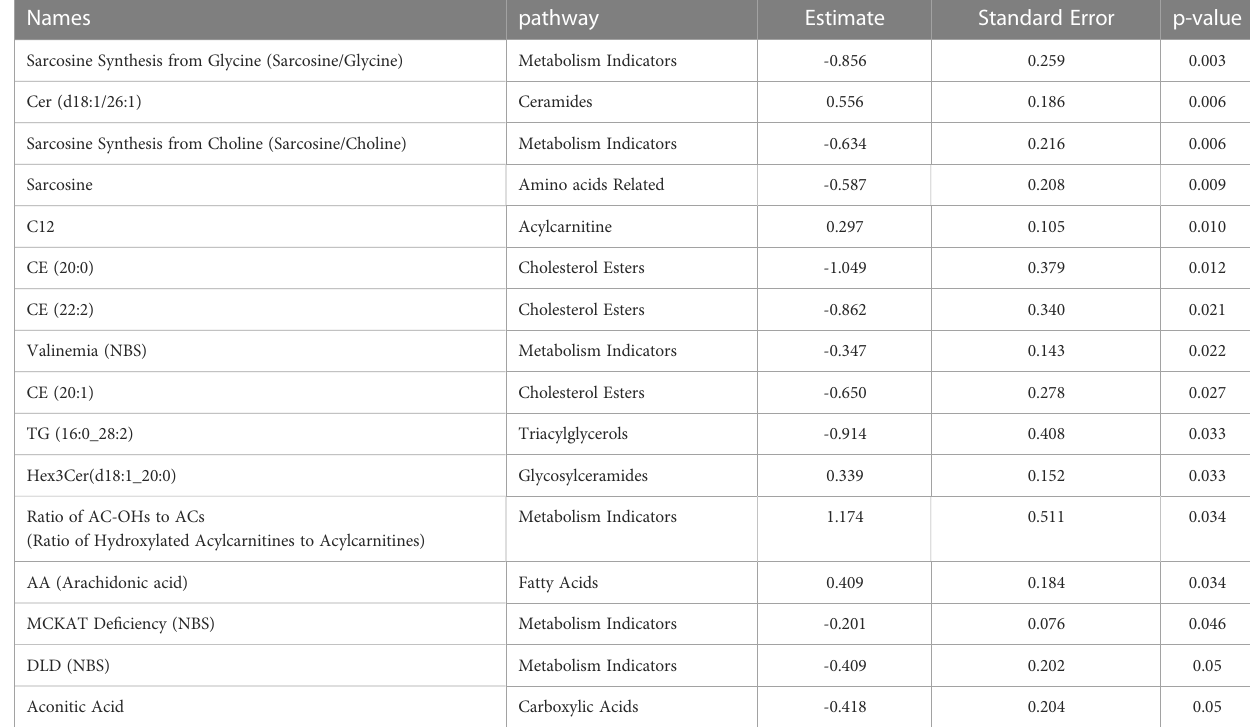
TABLE 2 Metabolites associated with BCG vaccination in diabetic patients with COVID-19. Names pathway Sarcosine Synthesis from Glycine